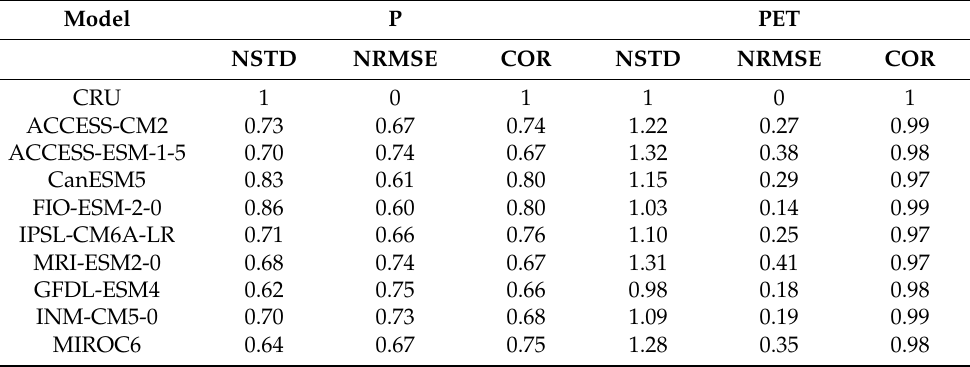
Table 2. Information of Simulation Capability of precipitation (P) and potential evaporation (PET)